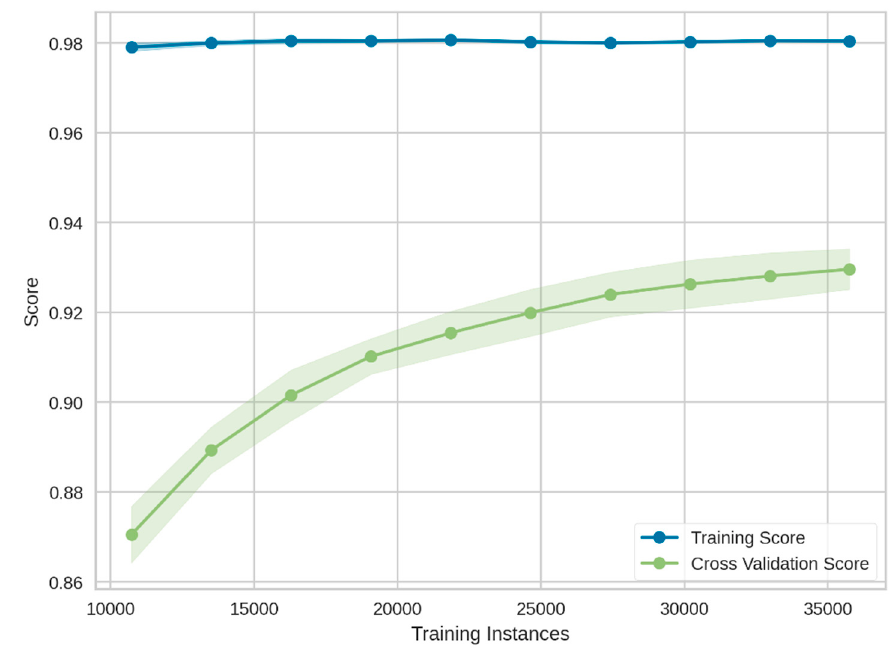
Figure 12. Training cross-validation accuracy score of the proposed model.